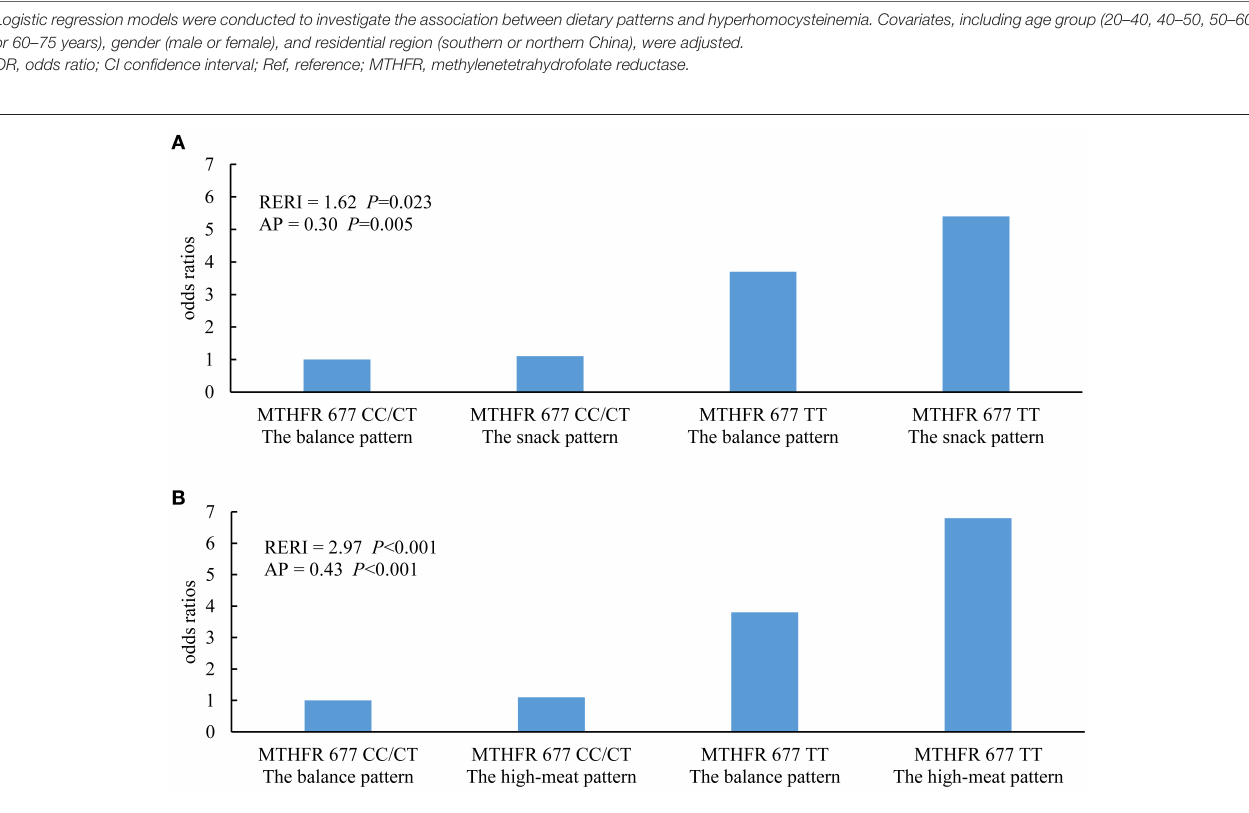
FIGURE 1 | Additive interaction between dietary patterns and MTHFR C677T genotypes. (A) Results of the balanced pattern vs. the snack pattern were presented. (B) Results of the balanced pattern vs. the high-meat pattern were presented. RERI, relative excess risk due to interaction; AP, attributable proportion due to interaction. Additive models were conducted to estimate the interactive effects, in which age group (20–40, 40–50, 50–60, or 60–75 years), gender (male or female), and residential region (southern or northern China) were